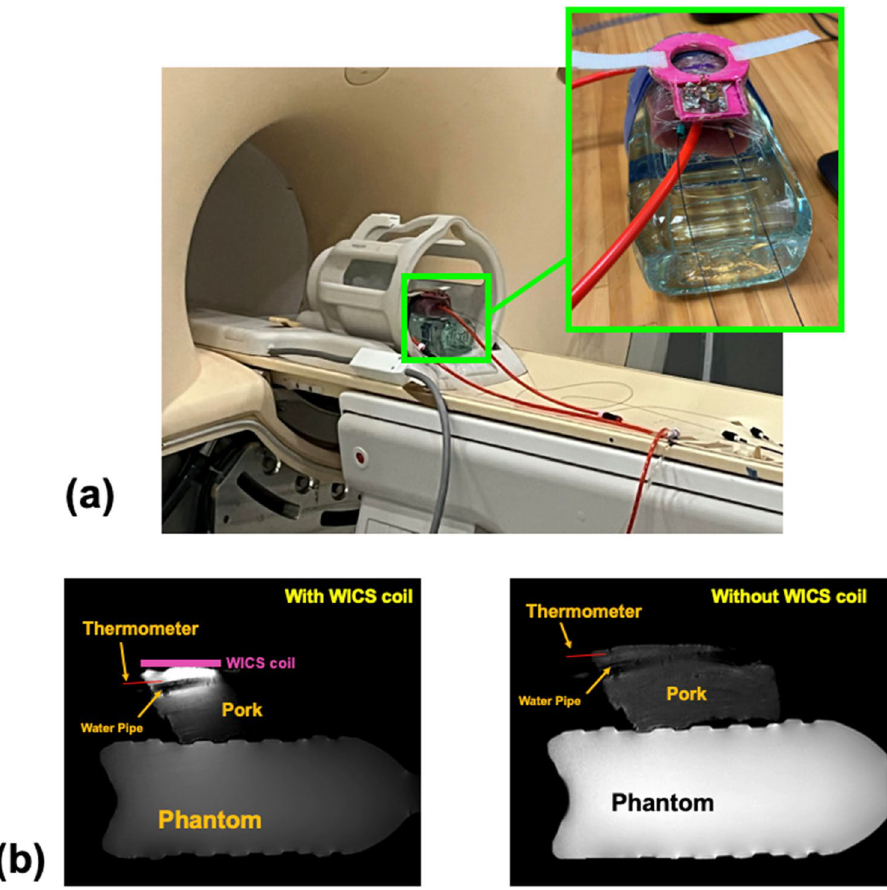
Figure 3. ( a ) Photograph and ( b ) experimental setup of validation study. A water pipe filled with circulating hot water was pierced through the pork tenderloin. Two fiberoptic thermometers were inserted to measure actual temperature inside the pork tenderloin to validate MR